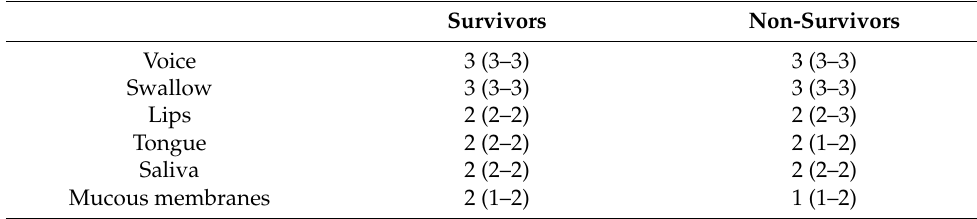
Table 4. Median OAG-F scores on